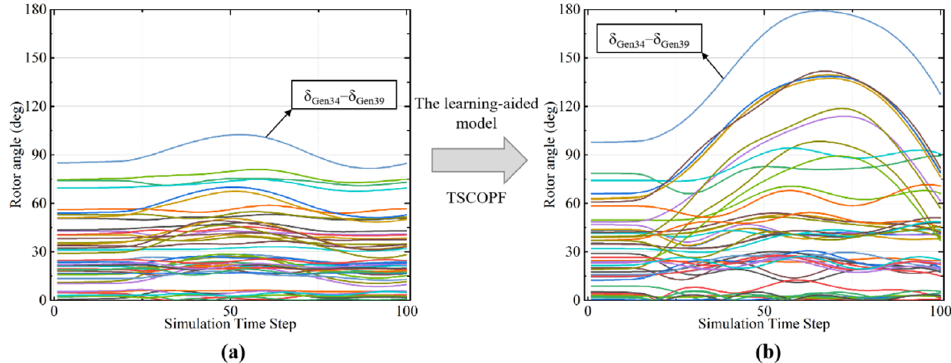
Figure 6. The post-fault transient trajectories of rotor angle differences of the test sample: ( a ) the trajectories after sample initial power flow calculation; ( b ) after TTC calculation.